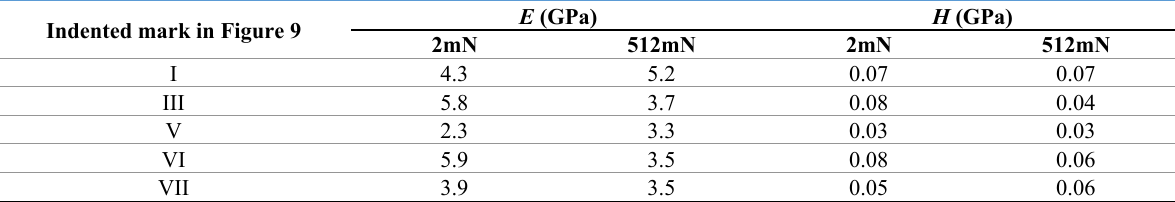
Table 6. Elastic modulus and hardness values for 32 mN and 512 mN of the indentations showed in Figure 9. Indented mark in Figure